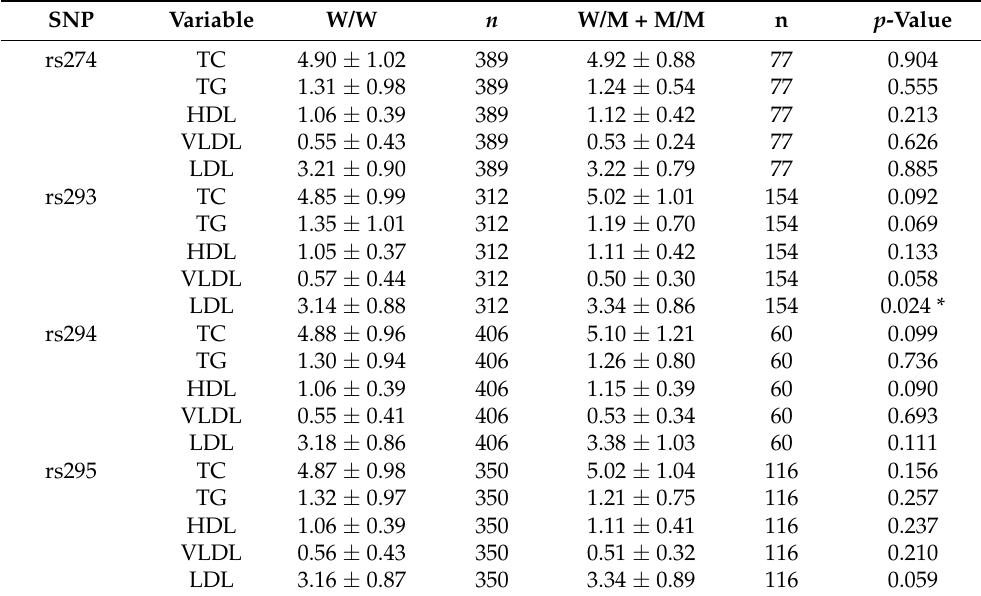
Table 4. Comparison of means between the genotypes of the selected LPL variants lipid profiles and body mass index (BMI) in Kuwaiti Arabs ( n =